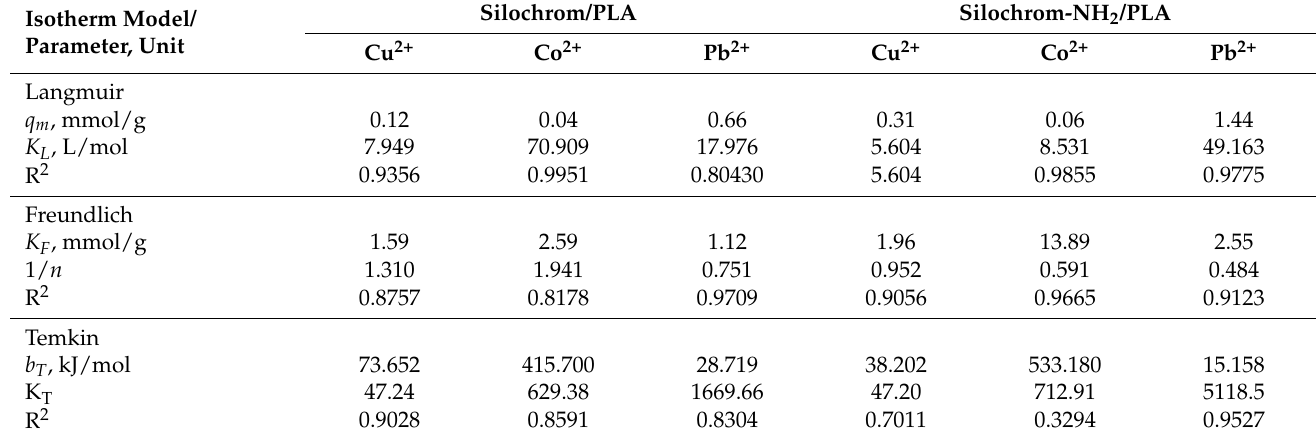
Table 3. The isotherm model parameters obtained for Cu(II), Co(II), and Pb(II) ions adsorption onto Silochrom/PLA and Silochrom-NH 2 /PLA